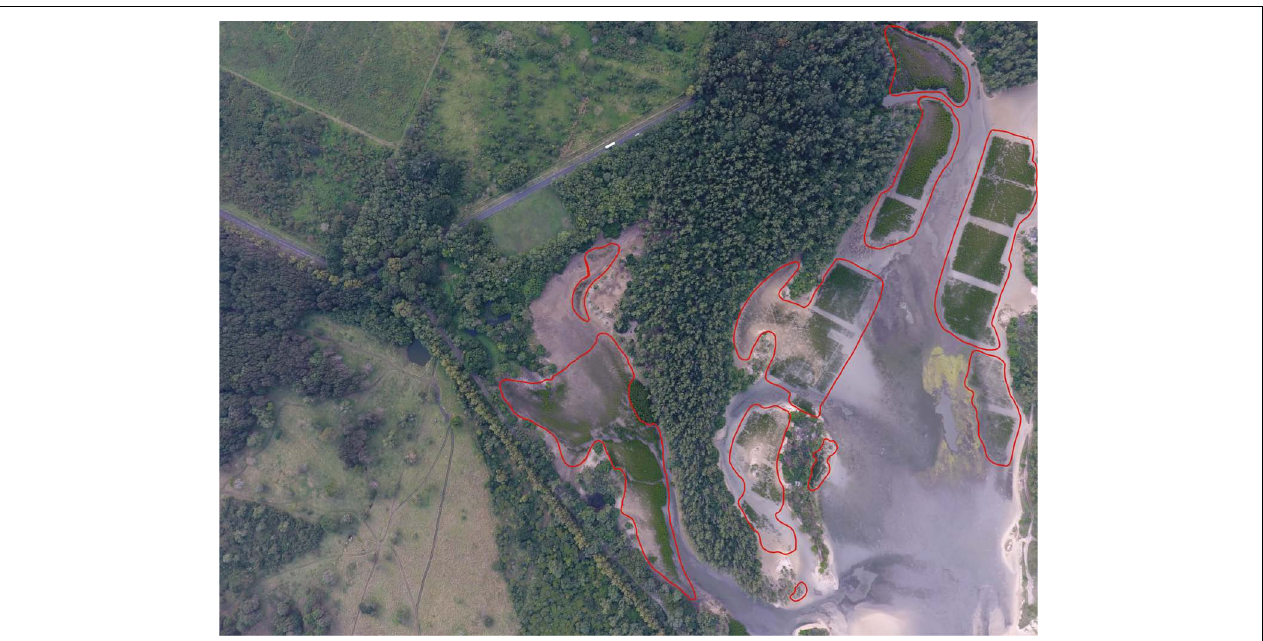
FIGURE 5 | Aerial image of mangrove regeneration; new mangrove evident as delineated and regular plantings (outlined in red). Drone image from